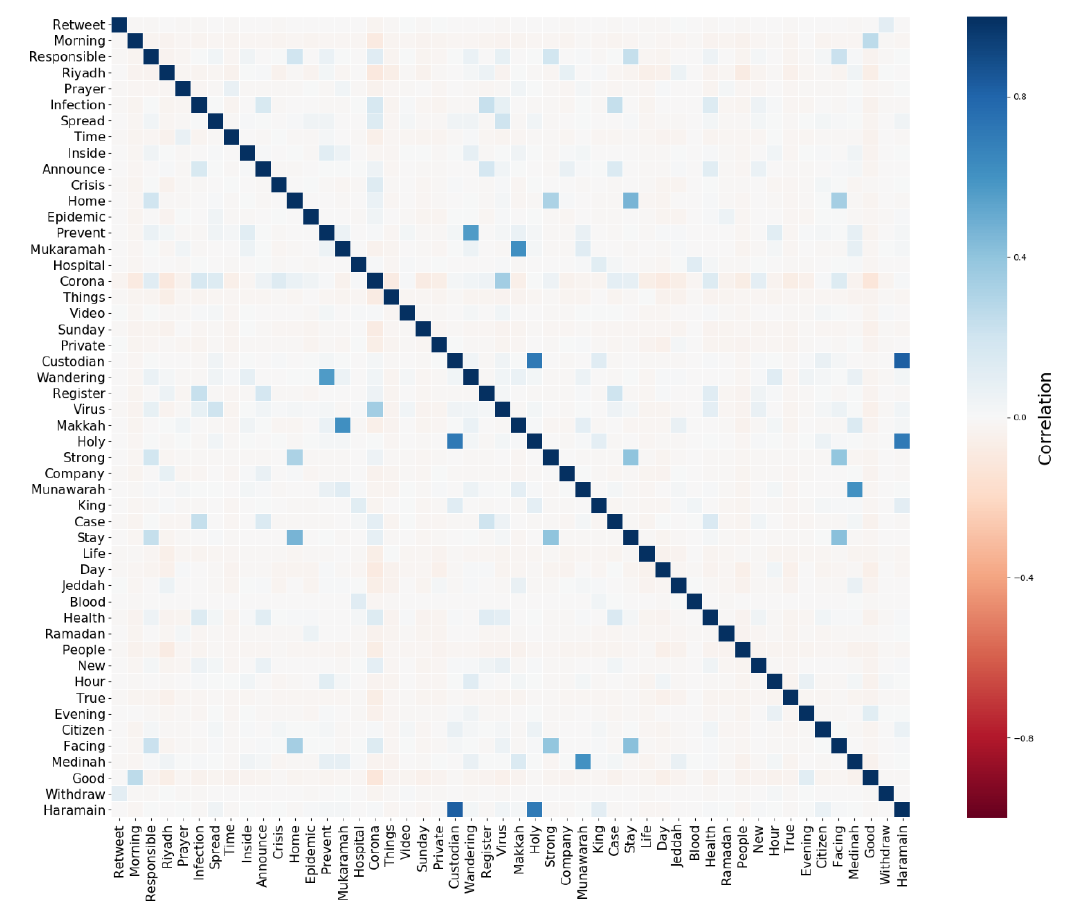
Figure 5. The correlation matrix of keywords.